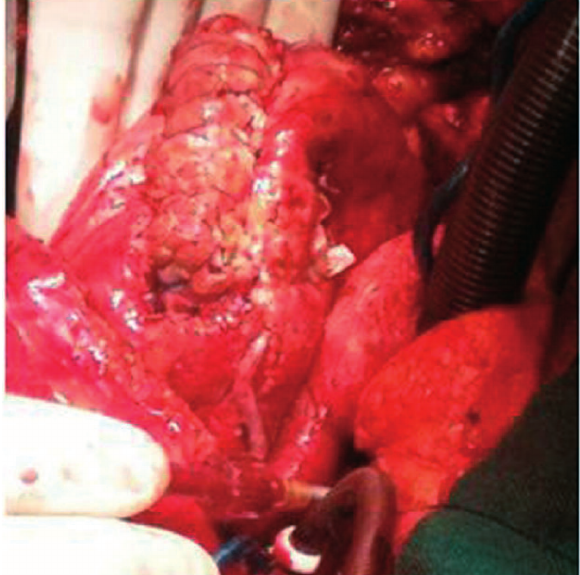
Fig. 2 - Aspecto cirúrgico final